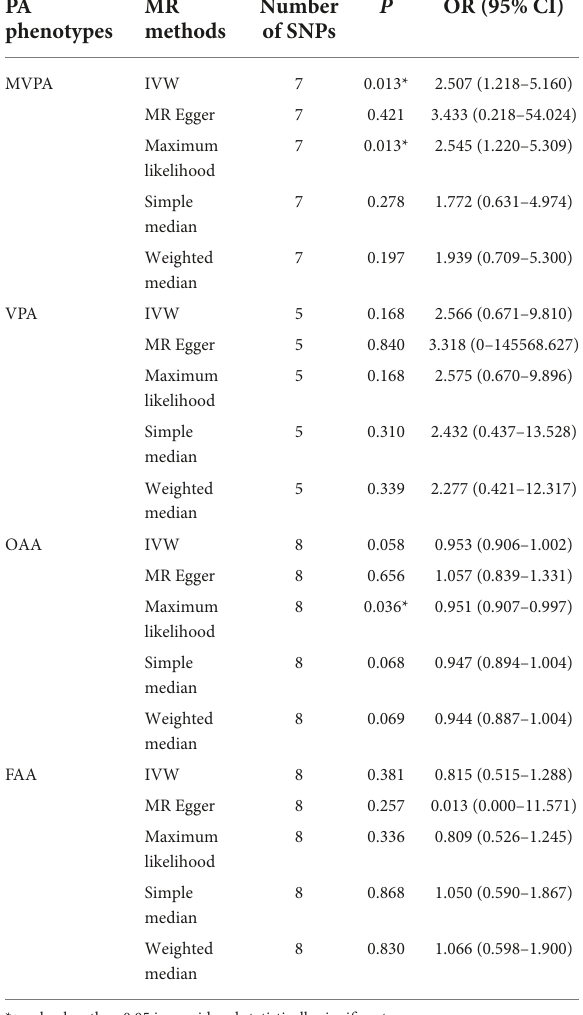
TABLE 1 Estimated association between physical activity phenotypes and amyotrophic lateral